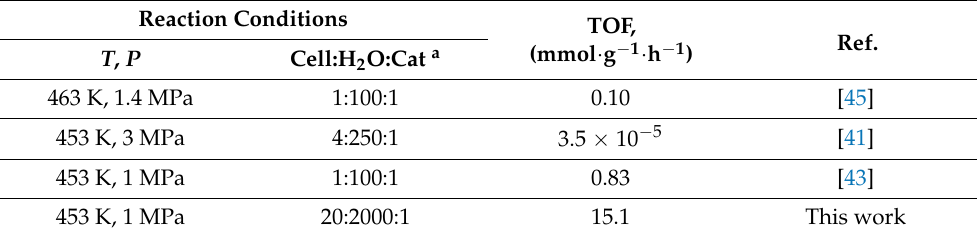
Table 6. TOF of ZrO 2 catalysts in cellulose hydrolysis-dehydration. Reaction Conditions